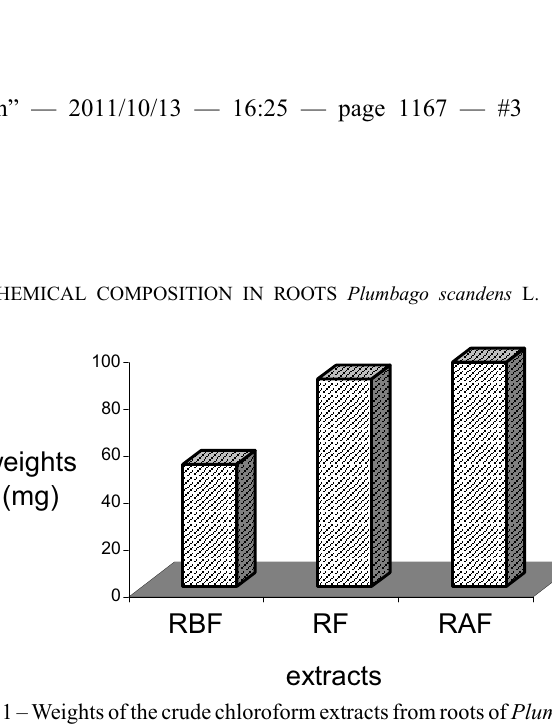
Fig. 1–Weightsofthecrudechloroformextractsfromrootsof Plumbago scandens collected in different development stages. RBF: roots before floration; RF: roots during floration; RAF: roots after floration.